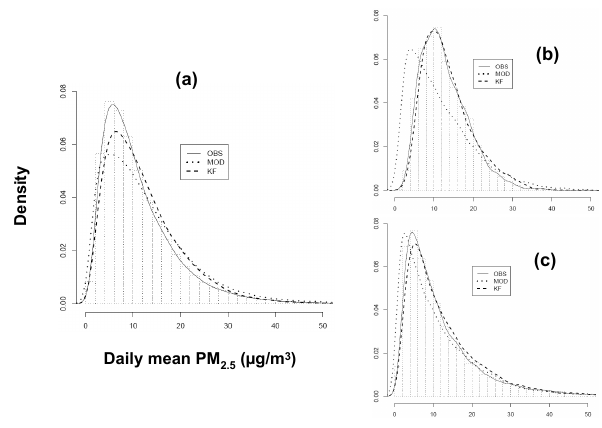
Fig. 6. The histogram of observed and the fitted Gaussian probability density function of observed, raw model forecast, and KF forecast daily mean PM 2.5 concentrations (µg/m 3 ): (a) Domain over entire year, (b) LM during warm season, (c) PC during cool season.